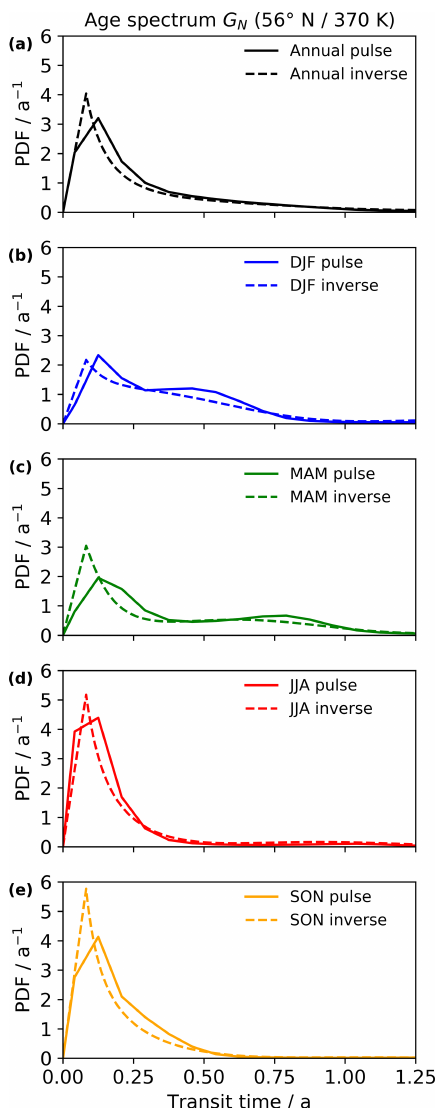
Figure 3. Normalized age spectra with reference at the northern hemispheric tropopause region G N at 56 ◦ N and 370K as annual (a) and seasonal (b–e) means. The solid line denotes age spectra from CLaMS pulse tracers, and the dashed line denotes inverse method age spectra.